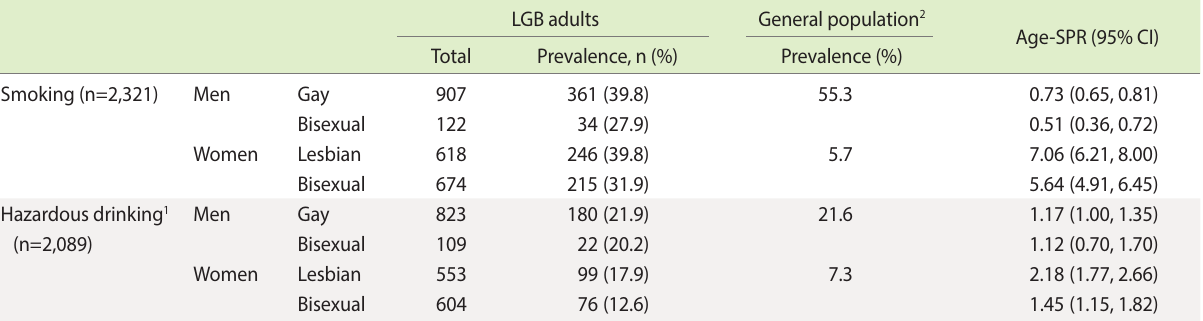
Table 6. SPR of smoking and hazardous drinking 1 between LGB population (2016) and the general population (2011) 2 in